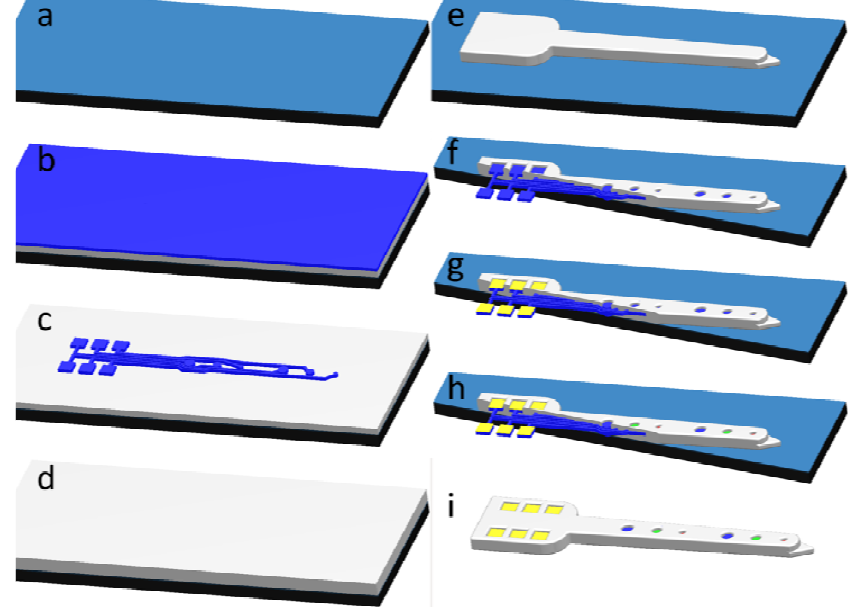
Figure 3. Fabrication process for all-diamond neural probes. ( a ) Si/SiO ( b ) Undoped- and doped-diamond growth; ( c ) Doped-diamond etch to define pads, interconnects and electrodes; ( d ) Undoped-diamond growth; ( e ) Undoped-diamond etch to pattern probe shape; ( f ) Undoped-diamond etch to expose pads and electrodes; ( g ) Gold bonding-pad deposition; ( h ) Optional diamond functionalization; ( i ) Probe release in